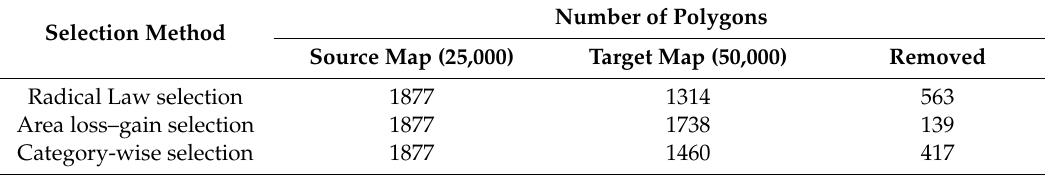
Figure 14. Effect of the selection method in the elimination operator. The large black rectangle in the original map denotes the map window used in Figure 16. The display scale is 1:50,000. The bottom row shows four magnified examples: OM (original map), M1 (Model 1), M2 (Model 2), M3 (Model 3). Table 3. Comparison of methods of selection in the elimination operator.